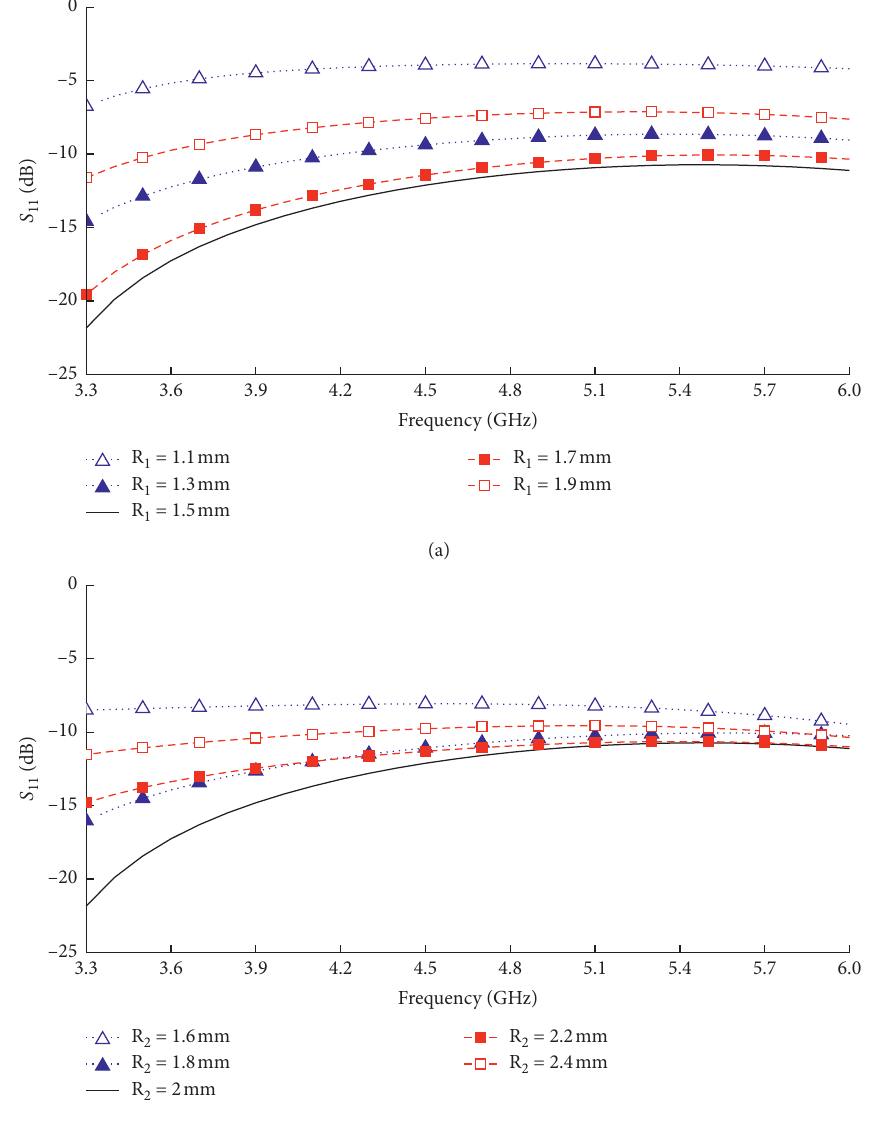
Figure 12: Parametric studies of the feeding network by changing the values of (a) R